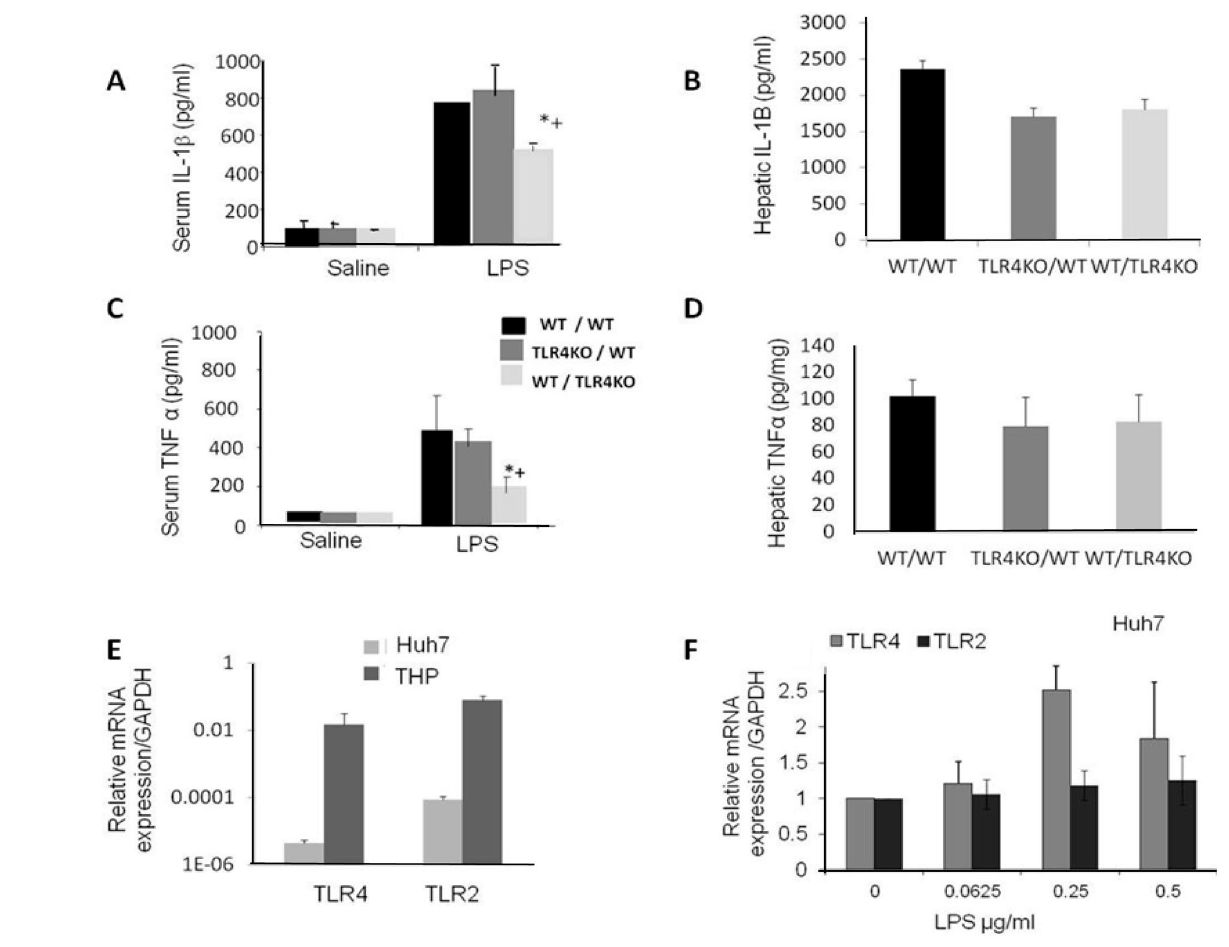
Figure 5. A,C: TNFα and IL-1β protein expression in chimeras in serum and liver. In all chimeras, both TNFα and IL-1β increased significantly at 4 hours post LPS challenge. The proinflammatory cytokine levels in chimeras expressing TLR4 in the liver were found to be significantly higher than the levels expressed in TLR4KO chimera livers ( * p<0.05 vs. WT/WT LPS treated ; + p<0.01 vs. + WT/WT saline-treated). Values are mean±SEM ( n=6 mice per group). B,D: Hepatic TNFα and IL-1β expression: No differences were observed between hepatic TNFα and IL-1β whether the livers expressed TLR4 or KO for TLR4. Values are mean ±SEM (n=3 mice per group). E: TLR2 and TLR4 mRNA expression level in a Huh7 cell line: Macrophages expressed a significantly higher level of TLR4 and TLR2 mRNA compared with the hepatocyte cell line (p < 0.0001). F: TLR2 and TLR4 mRNA expression following LPS treatment: LPS induced TLR4 activation in a hepatocyte cell line in a dose dependent manner while there was no change in TLR2 mRNA expression. The results are shown as the fold-change of the relative quantity of TLR mRNA normalized to GAPDH mRNA values; the control cells were assigned a value of 1 and results are normalized to controls. Each point represents the mean ±SEM of a set of data determined by at least 5